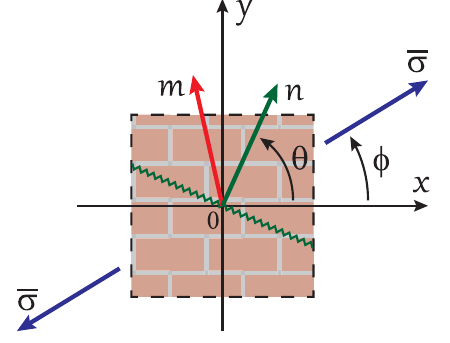
Figure 2. Localization ( n ) and polarization ( m ) vec- tors for uniaxial stress ¯ σ inclined by φ with respect the material x -axis